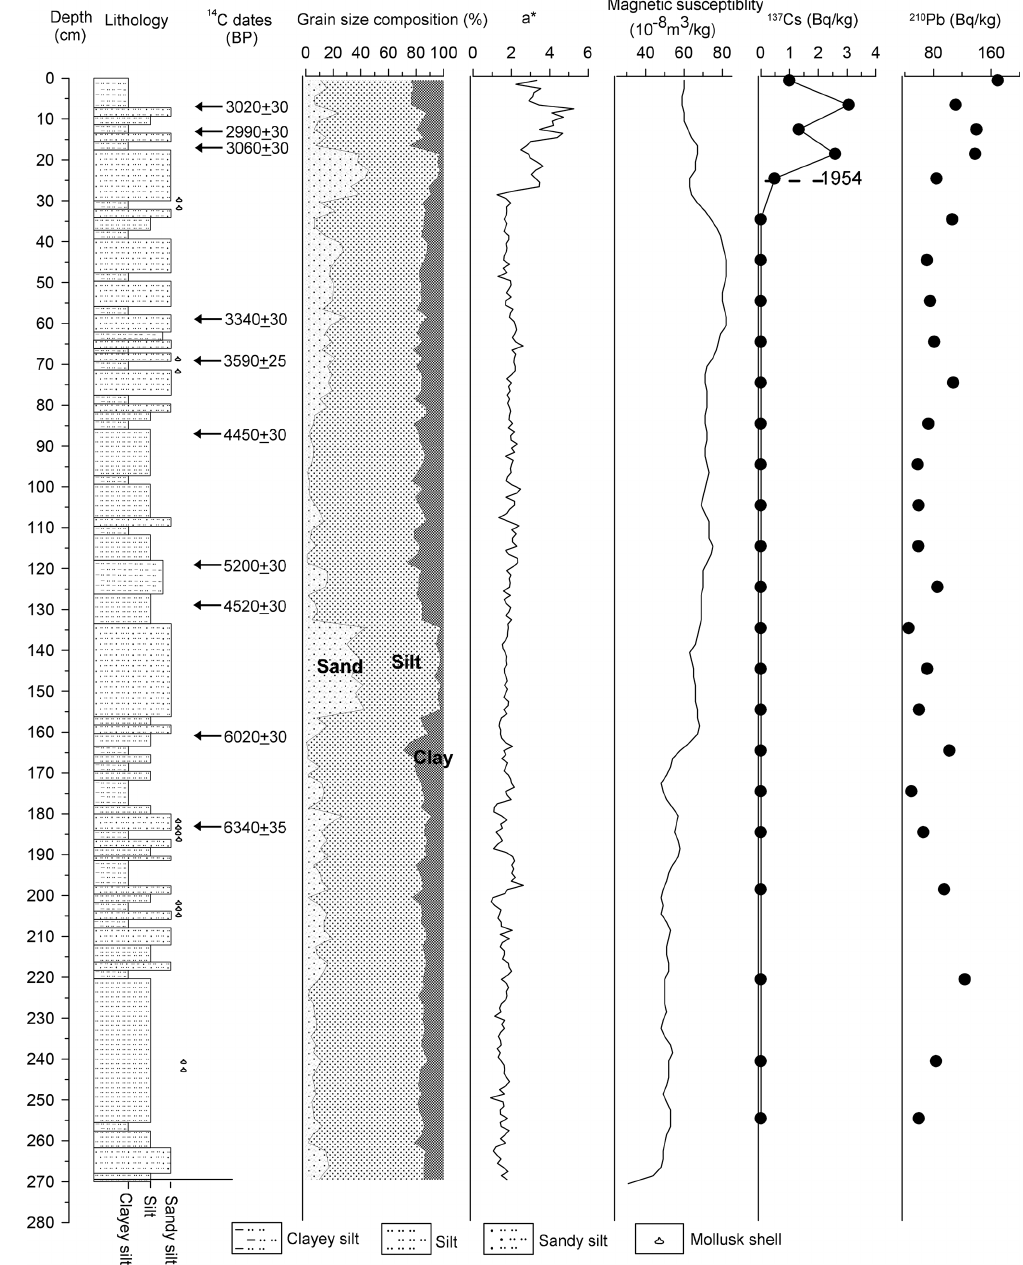
Figure 3. Lithology, grain size, color reflectance a ∗ , magnetic susceptibility, and activity profiles for 137 Cs and 210 Pb of core CJ06-435.